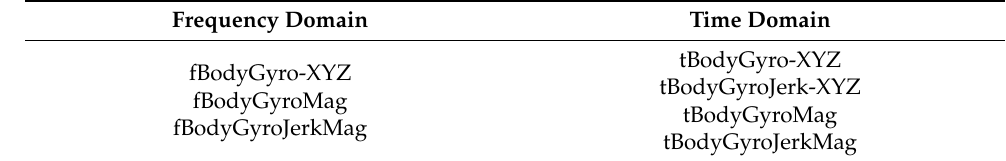
Table 1. Accelerometer sensor features